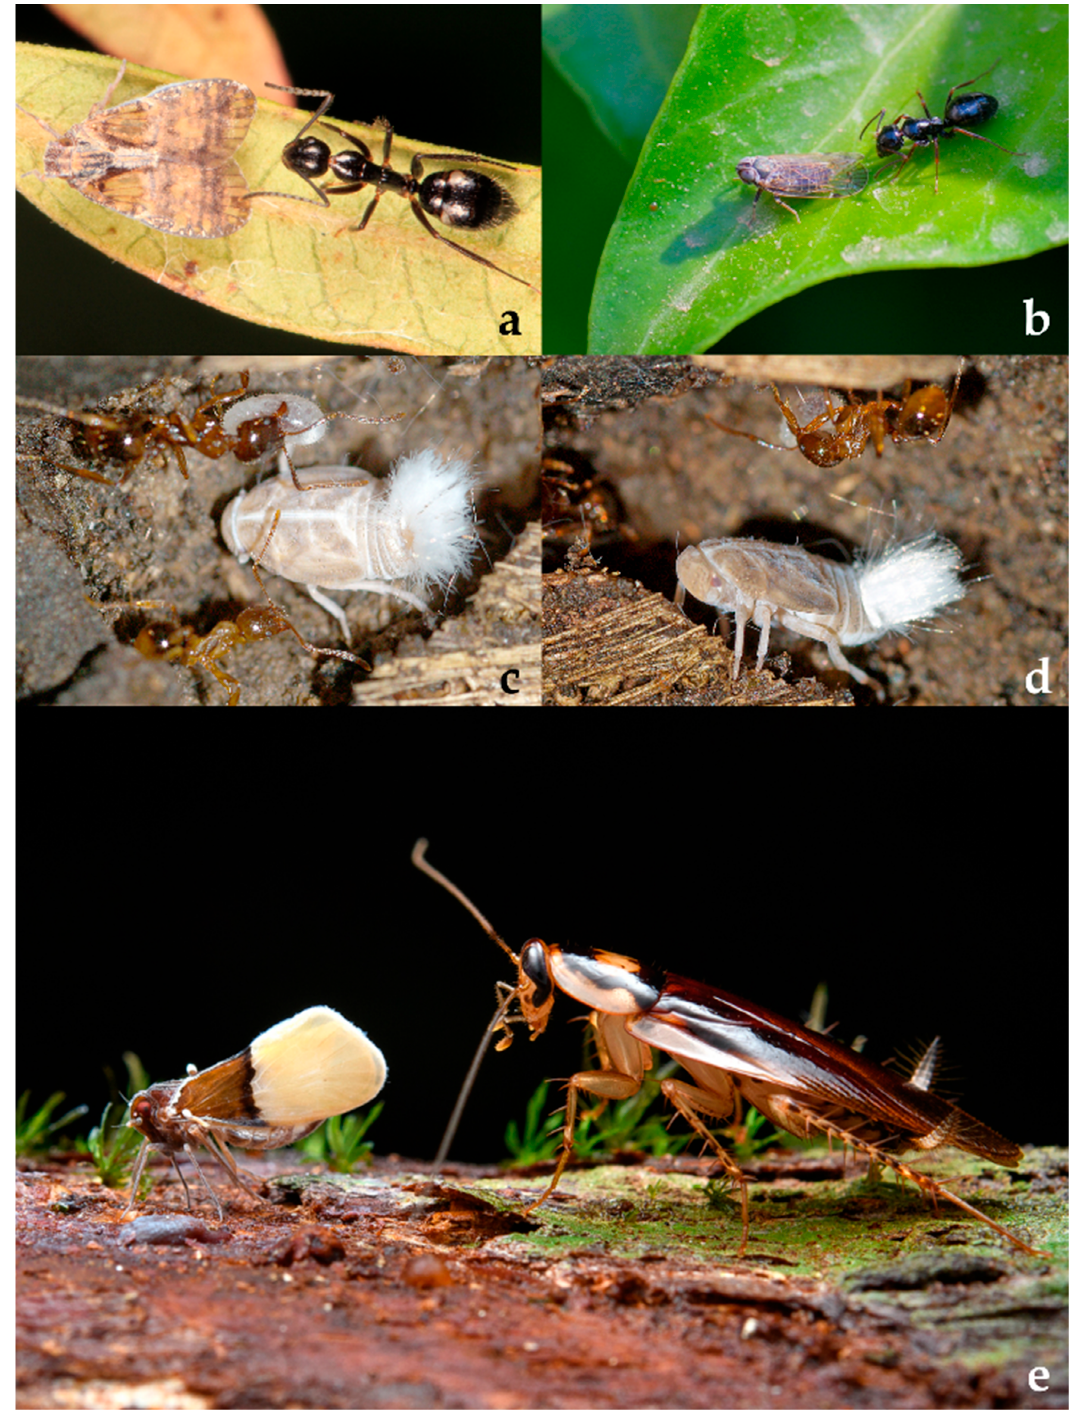
Figure 3. Cixiidae: ( a ) Bothriocera sp. tended by Formicidae: Formicinae: Camponotus sexguttatus (Fabricius, 1793), USA: Florida, Pinelands, Everglades National Park, Homestead, 07.12.2015, obs. J. Gallagher; ( b ) Hyalesthes sp. tended by Formicidae: Formicinae: Camponotus piceus (Leach, 1825), France: Provence-Alpes-Côte d’Azur, Solliès-Toucas, 43°11 ′ 38.6 ″ N 6°00 ′ 33.2 ″ E, 29.07.2021, obs. B. Noguès; ( c , d ) Reptalus sp. tended by Formicidae: Myrmicinae: Aphaenogaster subterranea (Latreille, 1798), Bulgaria: Eastern Rhodopes Mt., Oreshino vill., 41°28 ′ 19.3 ″ N 26°05 ′ 30.0 ″ E, 243 m, 20.04.2012, nymphs in ant nest under stone, obs. I. Gjonov, A. Lapeva-Gjonova; ( e ) Singabenna praestans (Walker, 1857) tended by Blattodea indet., Malaysia: Sarawak, Borneo, Bako National Park, 1°42 ′ 44 ″ N 110°26 ′ 46 ″ E, 07.01.2021, obs. C. Lee.